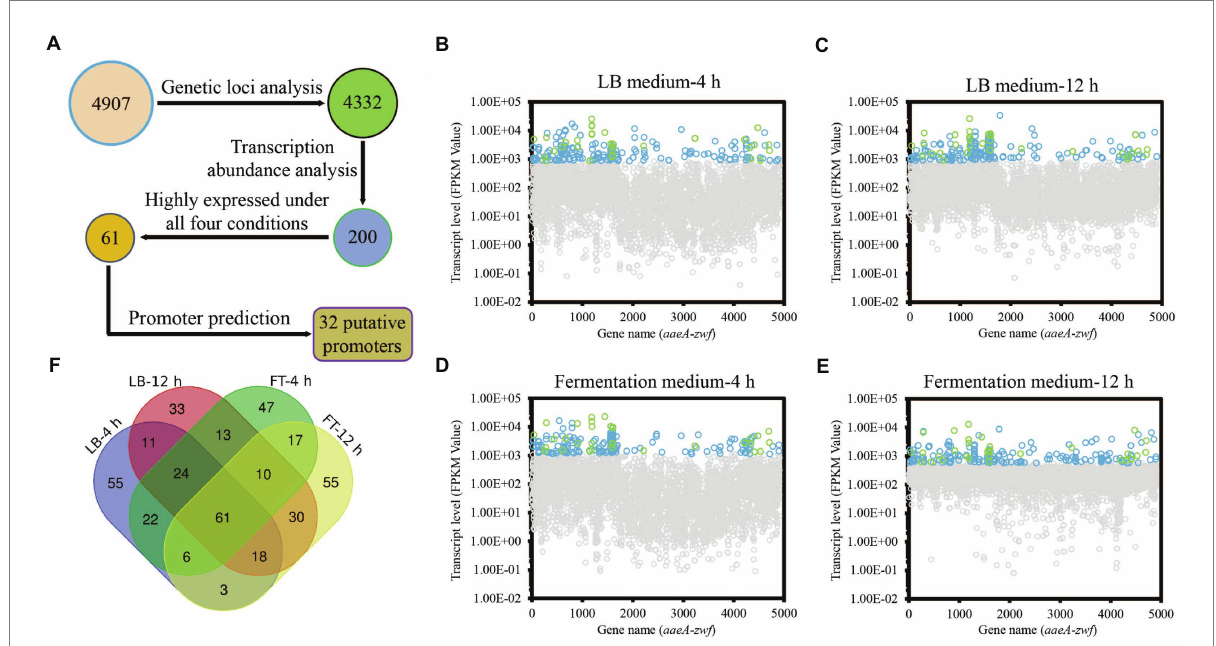
FIGURE 2 Rational selection of strong constitutive promoters in Serratia marcescens . (A) The flowchart for selection of strong constitutive promoters from the transcriptomic data. (B) Expression levels of the S. marcescens genes in LB medium at 4 h. (C) Expression levels of the S. marcescens genes in LB medium at 12 h. (D) Expression levels of the S. marcescens genes in fermentation medium at 4 h. (E) Expression levels of the S. marcescens genes in fermentation medium at 12 h. For (B–E) , light blue indicates the top 200 highly expressed genes in each condition, light green indicates the putative strong constitutive promoters encoding gene after rational selection. (F) Venn diagram of the number of genes expression highly under all four conditions by RNA-seq. FT-4 h indicates the top 200 highly expressed genes in fermentation medium at 4 h. FT-12 h indicates the top 200 highly expressed genes in fermentation medium at 12 h. LB-4 h indicates the top 200 highly expressed genes in LB medium at 4 h. LB-12 h indicates the top 200 highly expressed genes in LB medium at 12